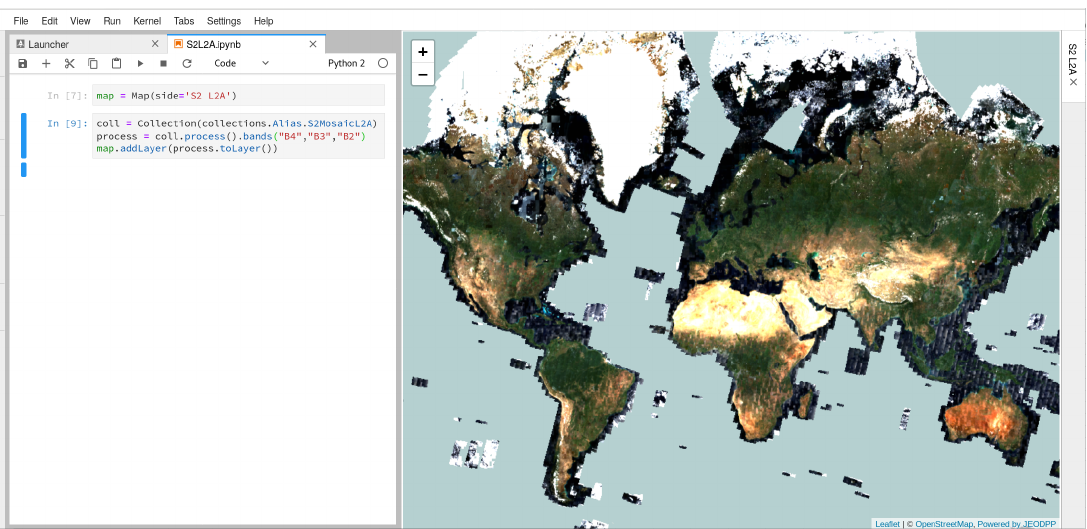
Figure 5. Sentinel-2 global composite based on a minimum set of overlapping images visualized from a JupyterLab notebook in